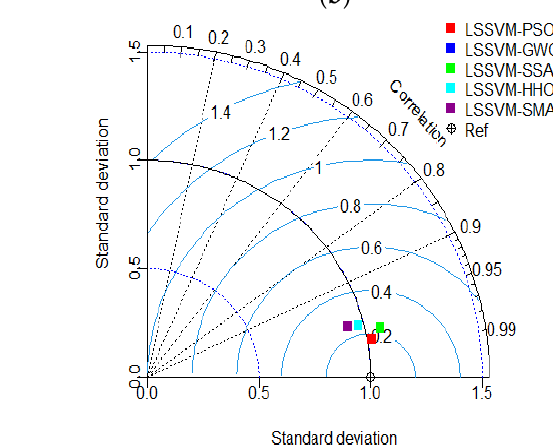
Figure 8. Taylor diagrams for the training ( a ) and testing ( b ) datasets.